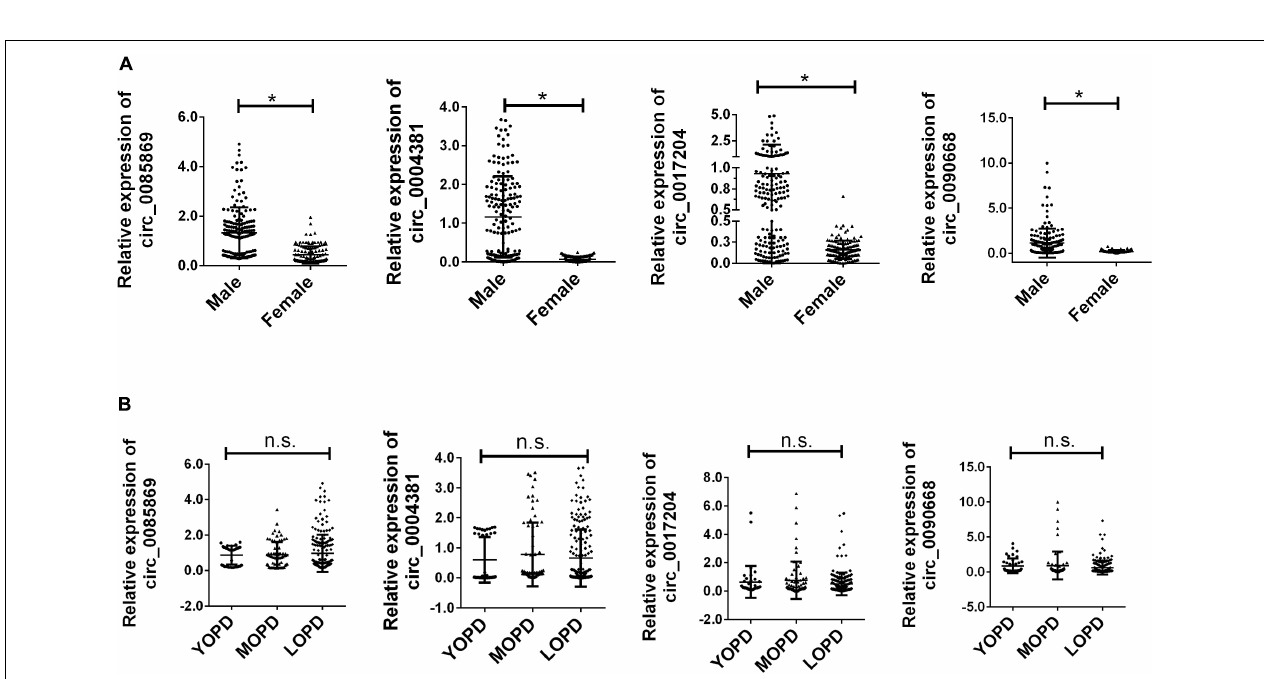
FIGURE 4 | Relative expression of circRNA panel in PD subgroups. (A) Relative expression of circRNA panel in males and females of PD. (B) Relative expression of circRNA panel in PD for different age groups of onset. Data was presented as mean ± SEM. * indicated p < 0.05, n.s. indicated no significant.